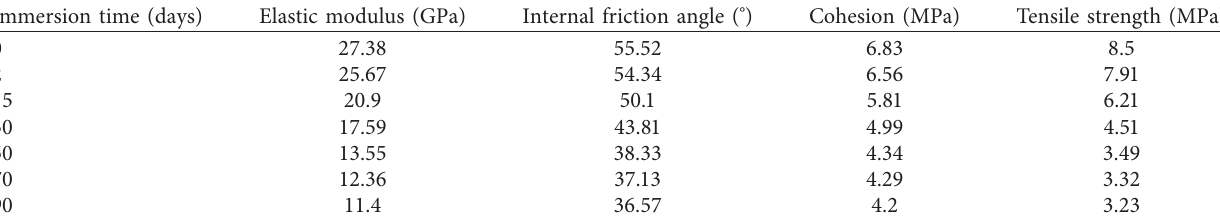
Table 1: Mechanical parameters in numerical modelling.